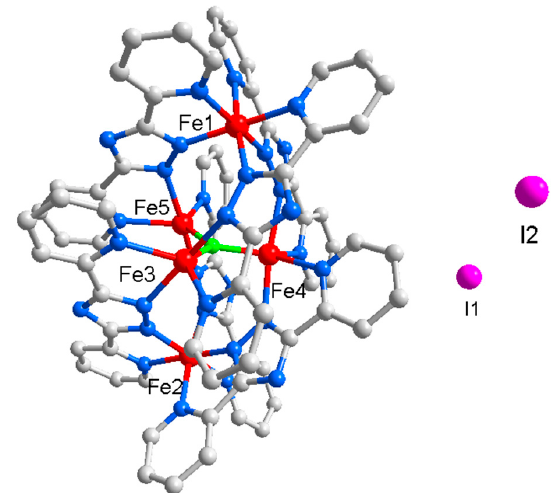
Figure 4. Structure illustrations of 3 : coordination geometries of the pentanuclear cation and I − anion. Hydrogen atoms are omitted.